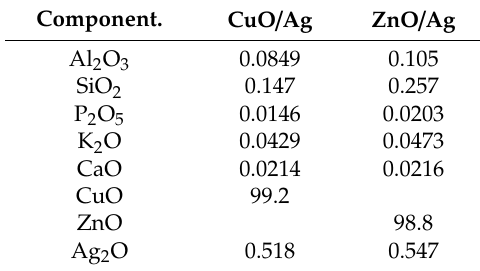
Table 2. X-ray fluorescence (XRF) analysis of the components of Copper Oxide / Silver and zinc Table 2. X - ray fluorescence (XRF) analysis of the components of Copper Oxide/Silver and zinc oxide / silver (ZnO / Ag) nanocomposites (in wt.%), adapted from reference [19]. oxide/silver (ZnO/Ag) nanocomposites (in wt.%), adapted from reference [19]. Component. CuO / Ag ZnO / Component. CuO/Ag